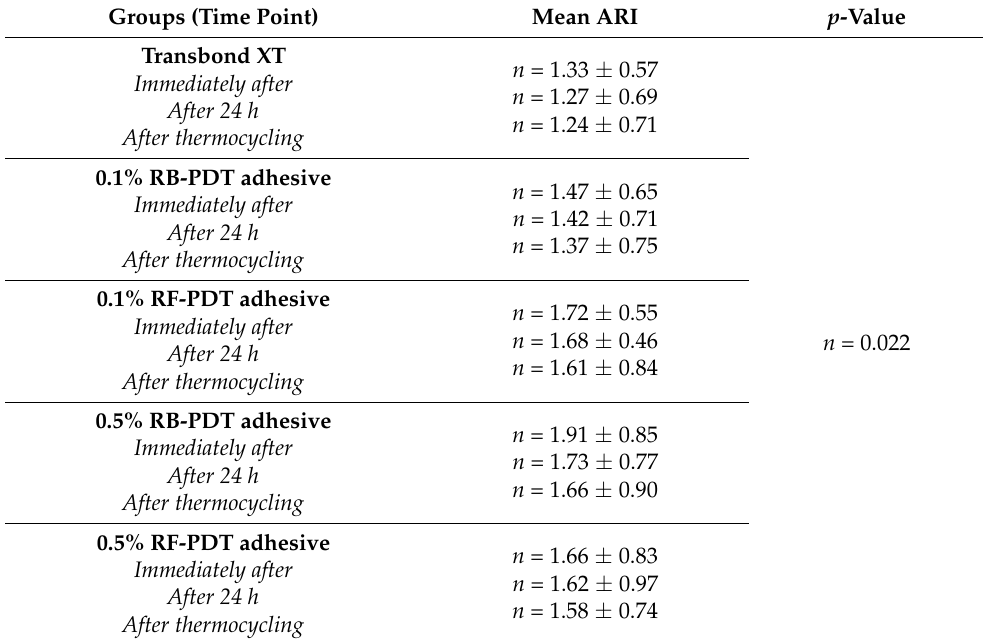
Table 2. Mean adhesive remnant index (ARI) scores for all groups immediately after photodynamic therapy (PDT), after 24 h and after thermocycling. Groups (Time Point) Mean ARI p -Value Transbond